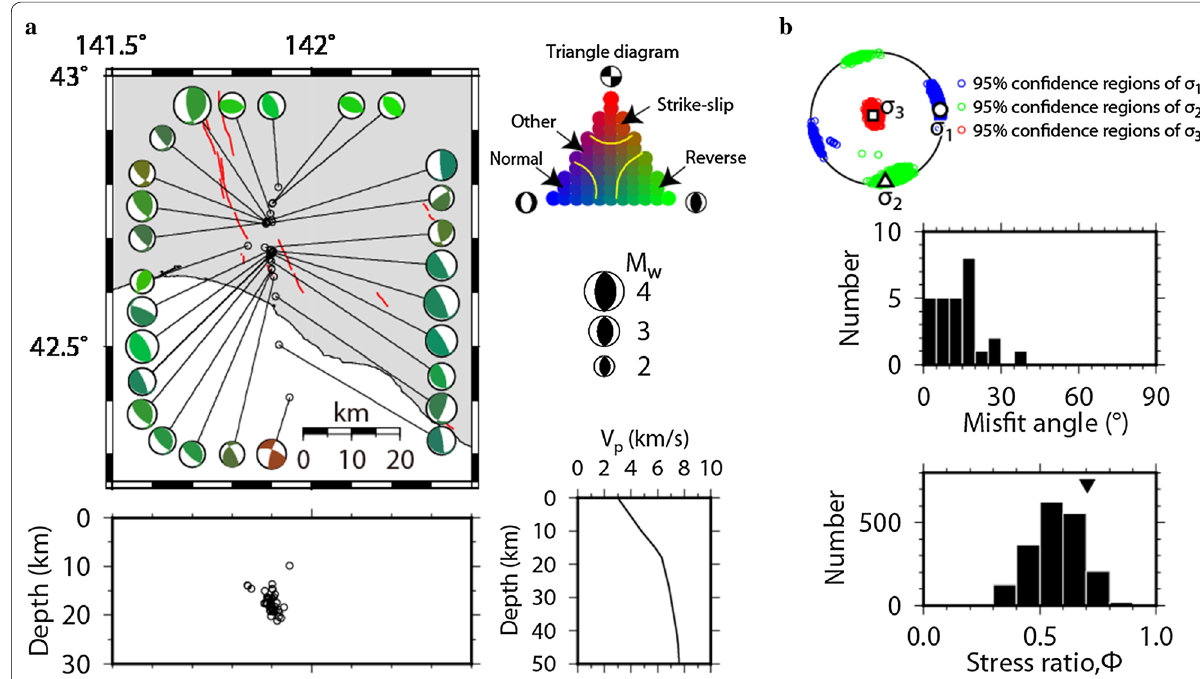
Fig. 2 a Focal mechanism solutions for the 27 aftershocks determined in this study (lower hemisphere of the equal-area projection) with colors used to differentiate between the reverse (green), strike slip (red), and normal faulting (blue) mechanisms. A triangle diagram (Flohlich 1992) with a color scale is presented at the top right. Open circles indicate relocated hypocenters derived using the velocity model shown in the bottom right. The S-wave velocity is assumed by scaling the P-wave velocity by a factor of 1 / √ 3 . b Results of the stress tensor inversion. The top panels show the principal stress axes with their 95% confidence regions plotted on the lower hemisphere stereonets. The middle panel shows the misfit angle for the data with respect to the best stress tensor determined by the stress tensor inversion. Here, the misfit angle represents the angular difference between the tangential traction predicted by the best solution and the observed slip direction on each focal mechanism. The bottom panel shows the frequency of the stress ratio φ , which belongs to the 95% confidence region. Inverted triangle represents the stress ratio of the best stress